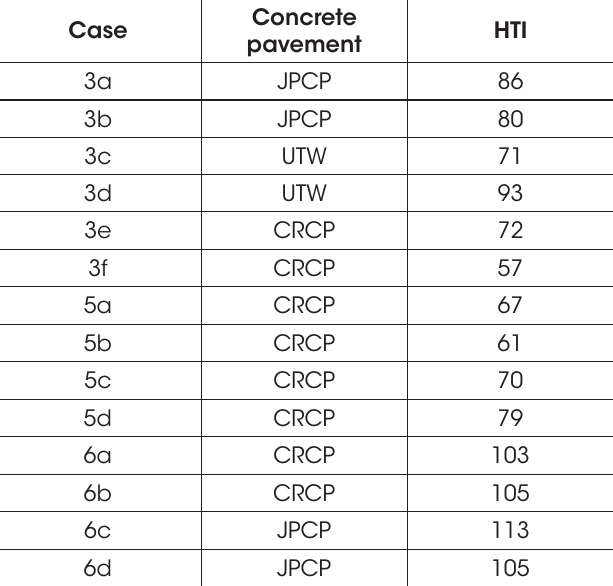
Hilbert Transform Indicator (HTI) for the cases